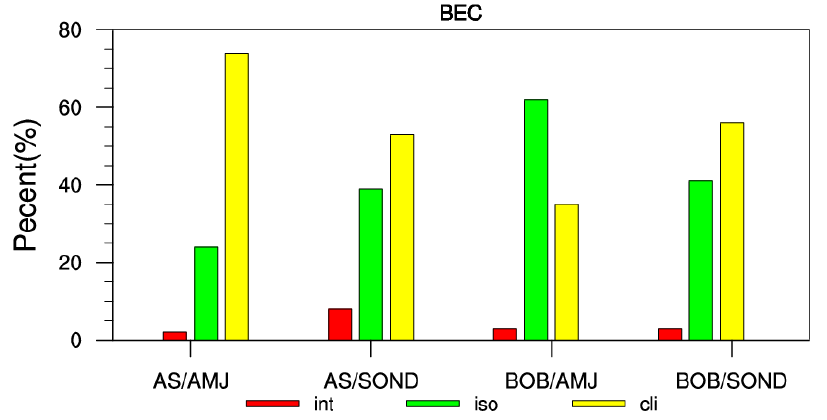
Figure 10. Similar to Figure 6b, except over the AS and BOB during AMJ and SOND.